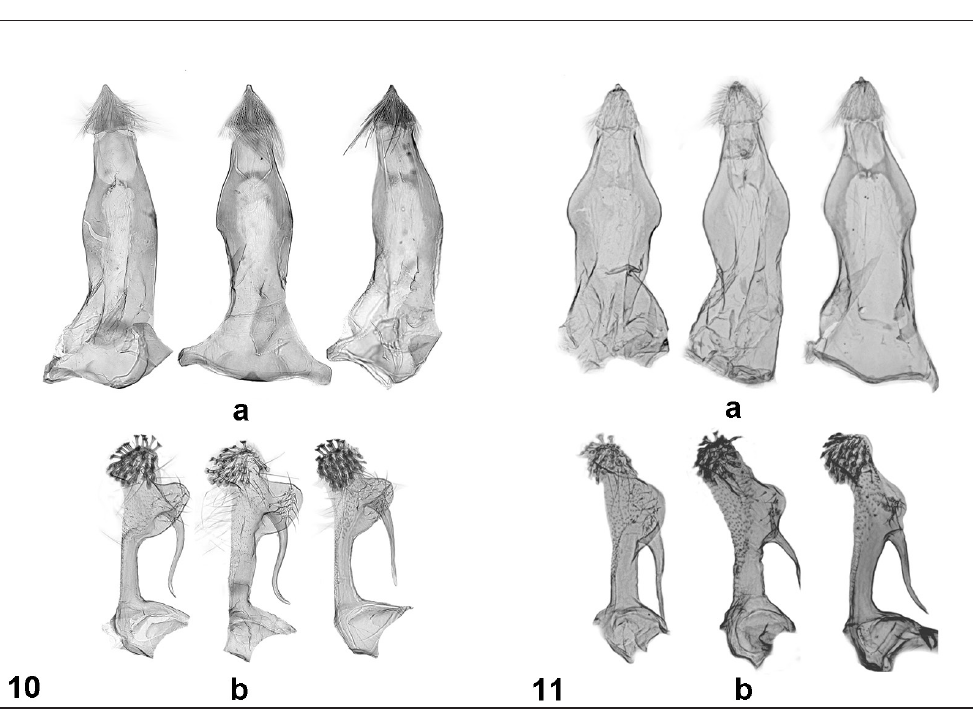
Figure 10–11. 10. A. innoxiella sp. n.; variation of male genitalia (HH6266, HH6303, OK5040). a. tegumen; b. left valva. 11. A. lineatella ; variation of male genitalia (KG935, KG3349, KG3365). a. tegumen; b. left